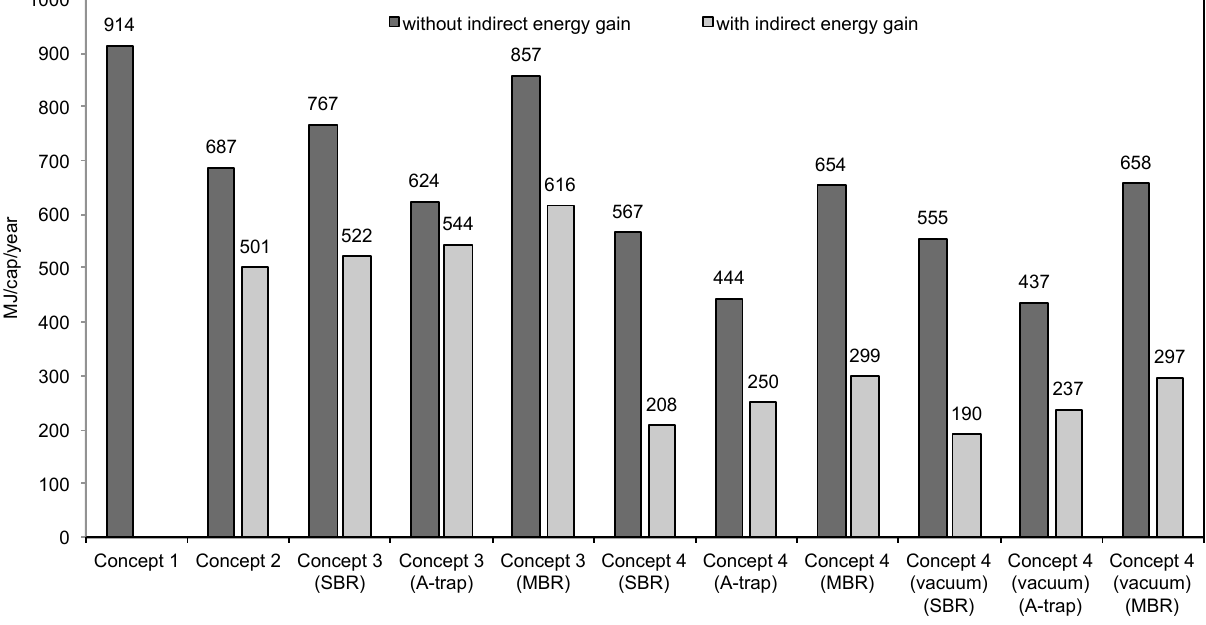
Figure 4. Total primary energy consumption in sanitation concepts with and without indirect energy gain from water saving and reuse, and nutrient